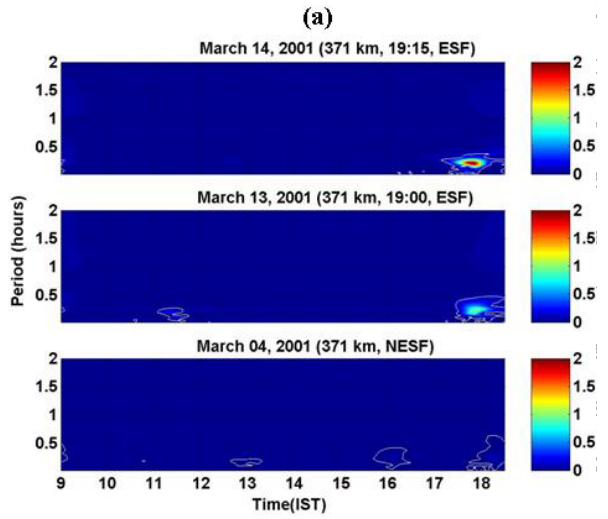
Fig. 1a. Wavelet periodogram of the intensity of the thermospheric 630 nm airglow emissions on ESF days (top and middle panels) and a non-ESF day (bottom panel) during the solar maximum year of 2001. The white solid contours denote the regions of the wavelet spectrum above the 95% confidence level. The numbers in the parenthesis indicates the maximum post sunset h 0 F and the onset time of ESF.